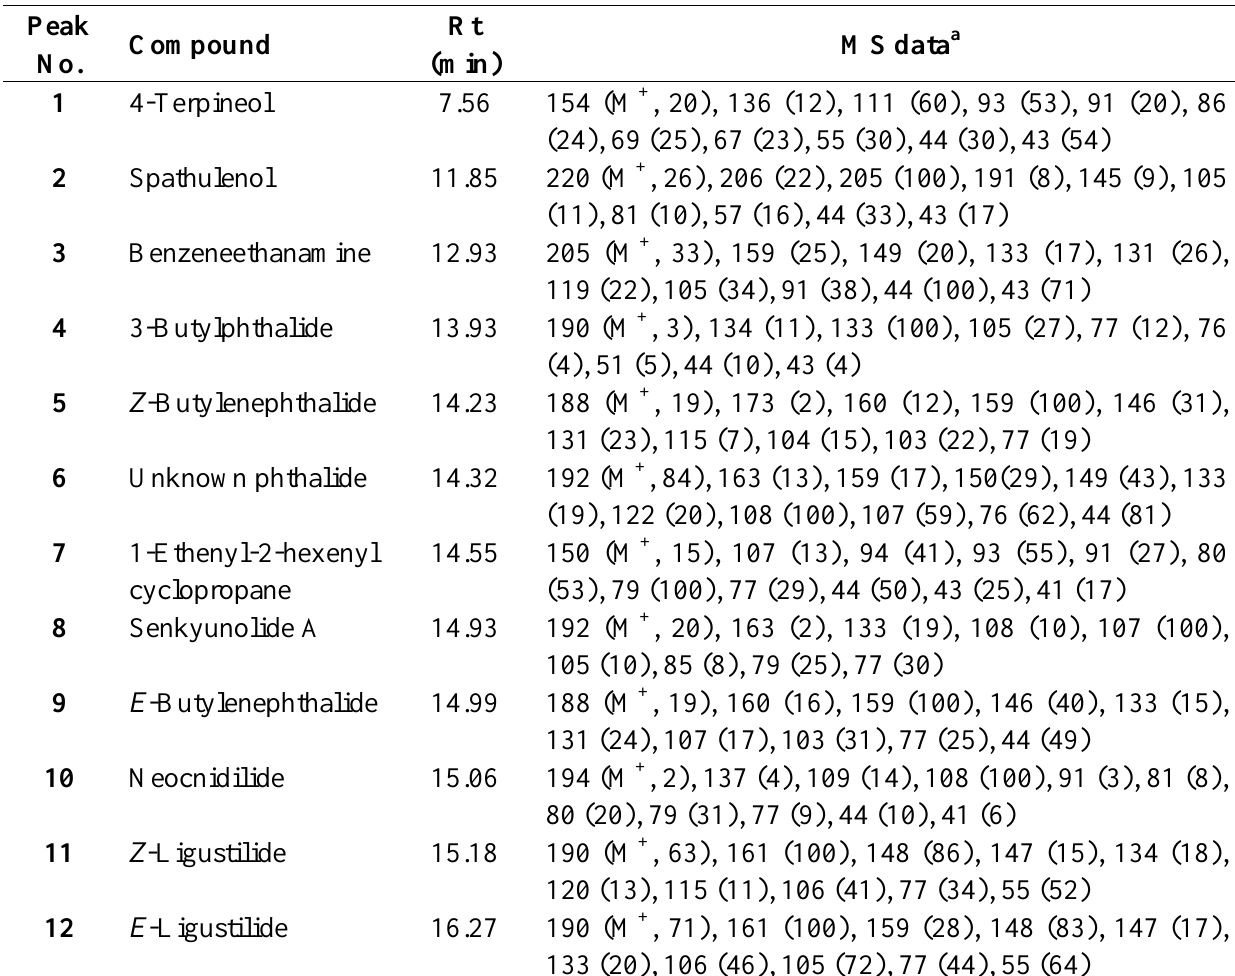
Table 1. MS data of 12 compounds identified from SWT, FSS, RA and